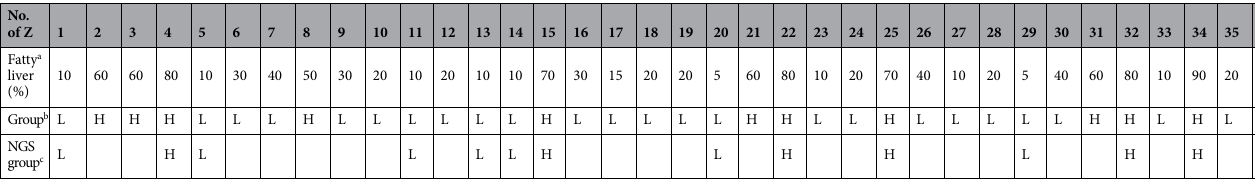
Table 1. Fatty change scores of 36 adult zebrafish after 8 weeks of high cholesterol diet. a The proportion of fatty change in liver was measured by two pathologists. More than 6 sections of a liver of a zebrafish were obtained and stained by Oil red O. The highest proportion value among 6 sections is representative score of fatty liver at each zebrafish. For example, 6 frozen sections of a liver were obtained from No.1 zebrafish, stained by Oil red O. 10% of fatty change in oil red O is the highest and representative score among 6 liver sections of No.1 zebrafish. b All zebrafishes were divided as two groups. H (high) group contains zebrafishes have not less than 50 proportion score. c Seven zebrafishes which have the highest proportion score of fatty liver were pooled as high group in RNA sequencing analysis. Z zebrafish, No. number, H high, L low, NGS next-generation sequencing analysis.